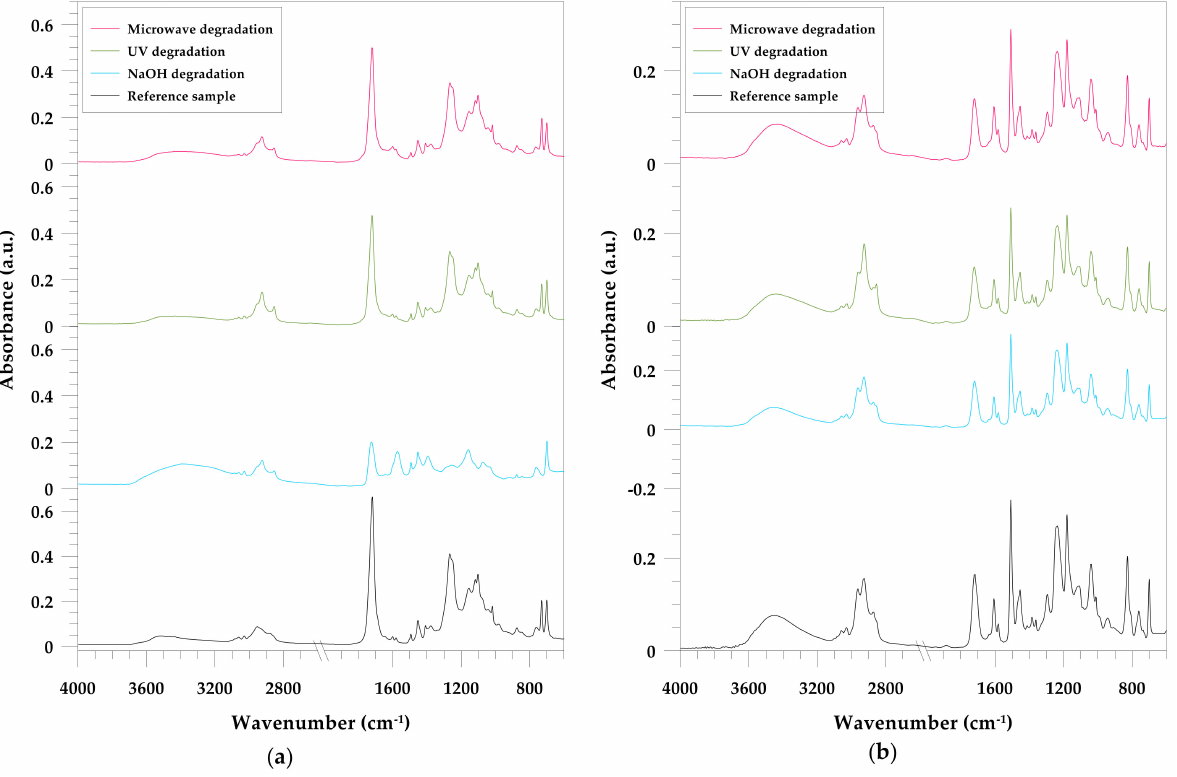
Figure 1. ATR/FT-IR spectra of the: ( a ) pure UPR; ( b ) pure